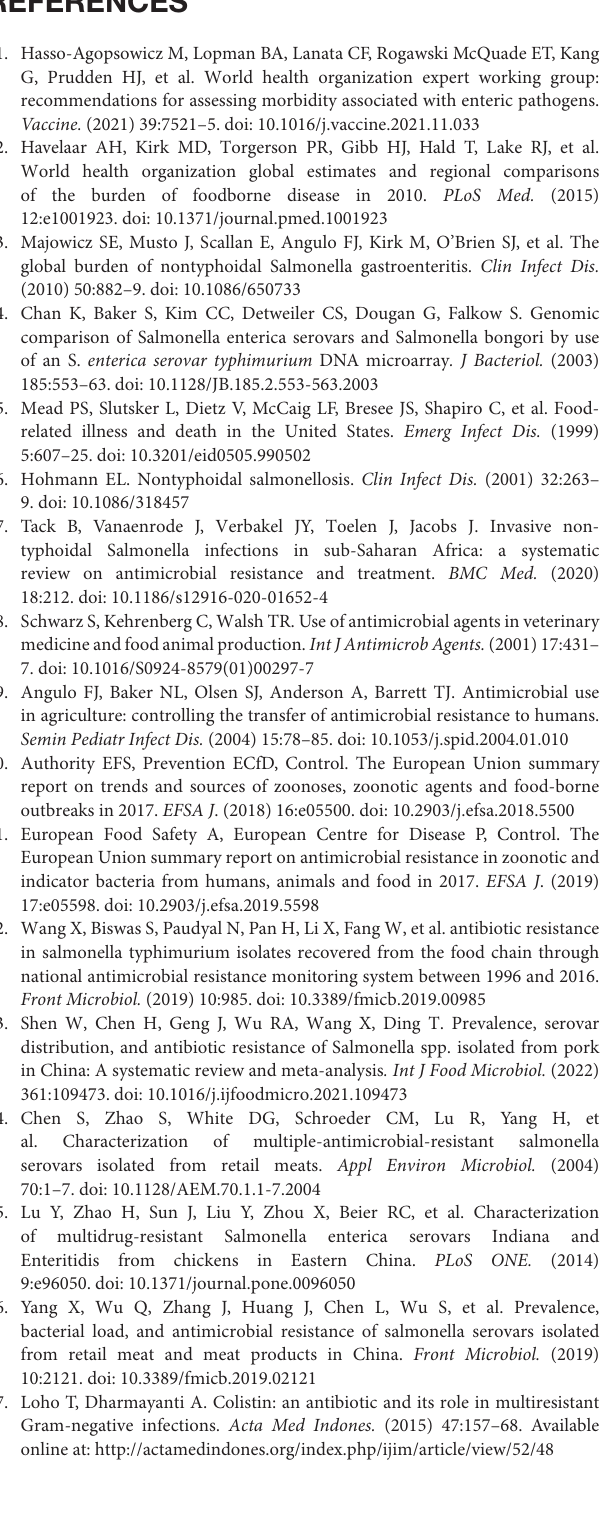
genomes were analyzed using Abricate with a minimum coverage of 90% and minimum identity of 90%